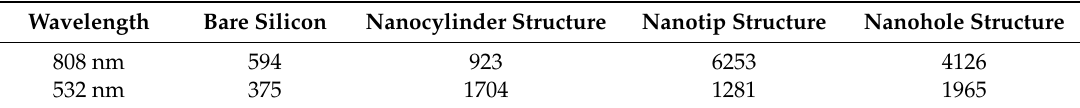
Table 1. The photoconductivity values (S / m) of the four models at 60 mW / mm 2 . Wavelength Bare